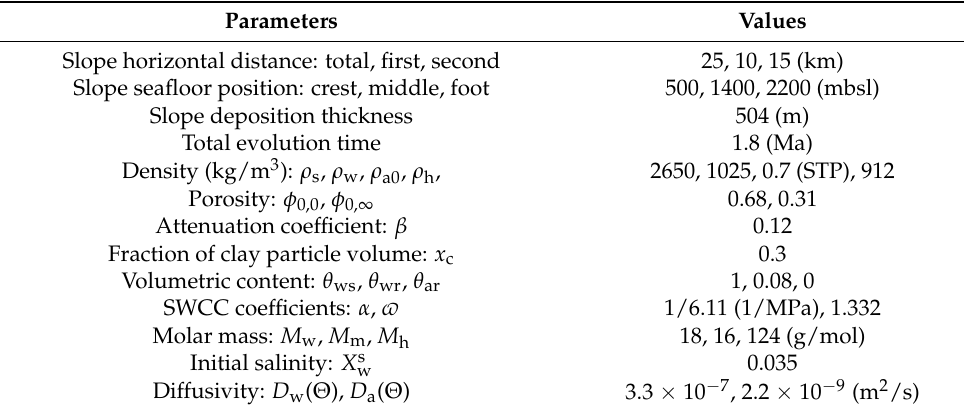
Table 2. Parameters used for deducing the basic scenario of stratigraphic-diffusive MH in Dongsha slope